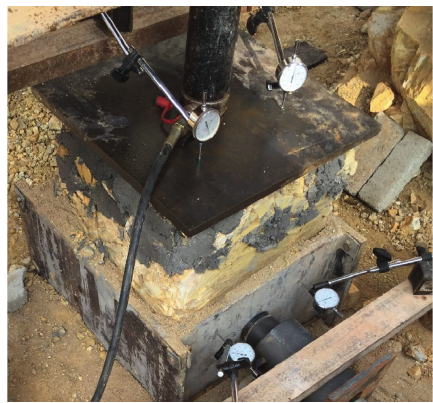
Figure 4: Picture of a part of the in situ test system.